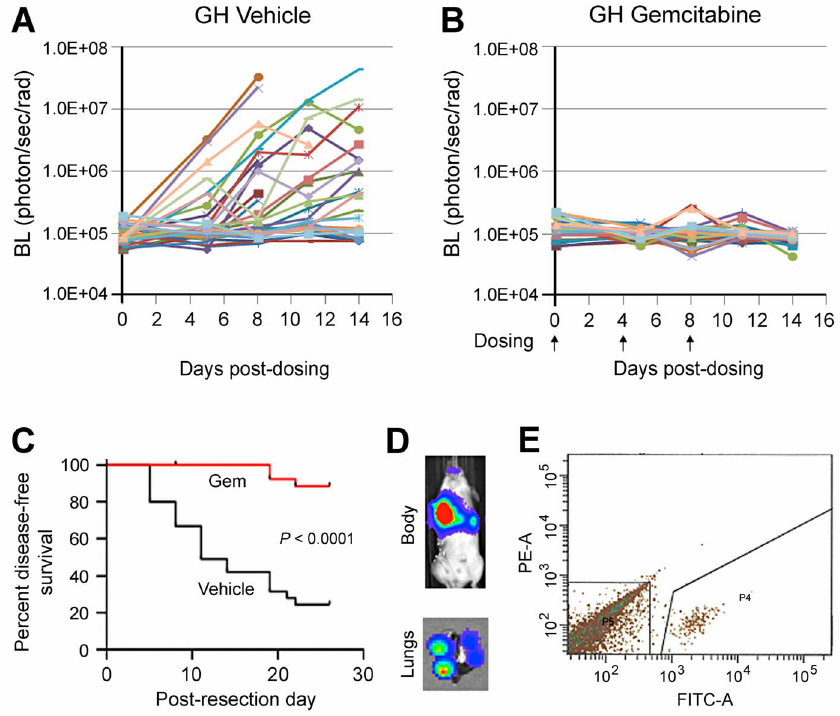
Figure 6. The GH mouse allows for consistent tracking of the progression of labeled metastases, their therapeutic responses and isolation in a preclinical adjuvant study. ffLuc-eGFP-labeled LLC tumors were transplanted subcutaneously into GH mice. Upon reaching 500 mm 3 , the primary tumors were resected. A and B , GH mice were randomized into control and treated groups to receive vehicle and gemcitabine at 25 mg/kg, respectively. Metastatic progression in mice was periodically monitored by BL imaging. Metastatic growth was efficient in untreated GH mice ( A ) but suppressed by gemcitabine ( B ). C , Kaplan-Meyer analysis showed that survival was significantly shorter in control compared to treated GH mice. D and E , GFP + cancer cells can be readily isolated from whole lungs of GH mice. The lungs were harvested from control GH mice, made into a single-cell suspension, and subjected to sorting by FACS to isolate GFP + cells. The representative result from mouse # 806 is shown. The in vivo image of mice and ex vivo image of lung ( D ) showed BL signal from pulmonary metastases and individual lung nodules, respectively. The GFP + cancer cells were successfully isolated from whole lung by FACS sorting (P4 subpopulation in E ).